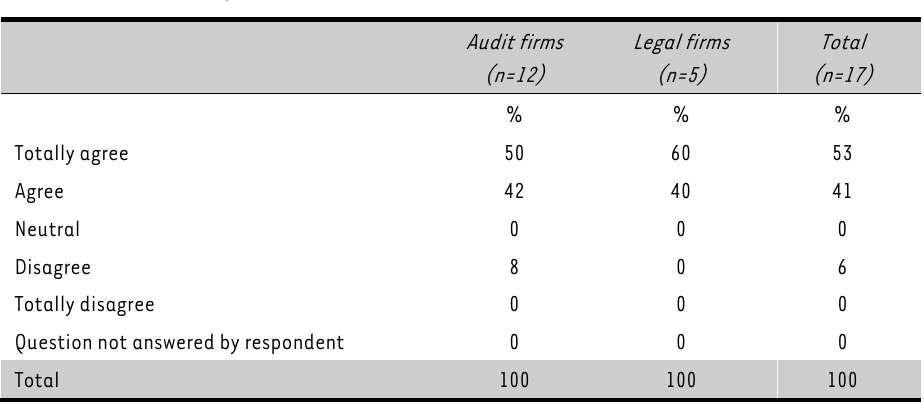
TABLE 11: Results of question